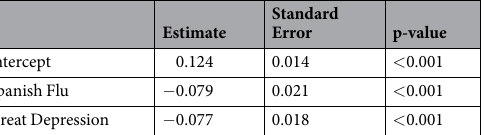
Table 2. Model summary for the relationship between environmental harshness and sex ratio at birth inclusive of our three time periods (n births = 63,432). Time periods Spanish Flu and Great Depression values are compared to the Roaring ‘20 s, while excluding inter-era births.